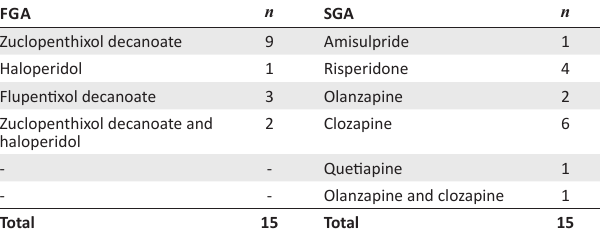
TABLE 2: First-generation antipsychotics and second-generation antipsychotics prescribed for male inpatients with severe mental illness at Weskoppies Psychiatric Hospital, South